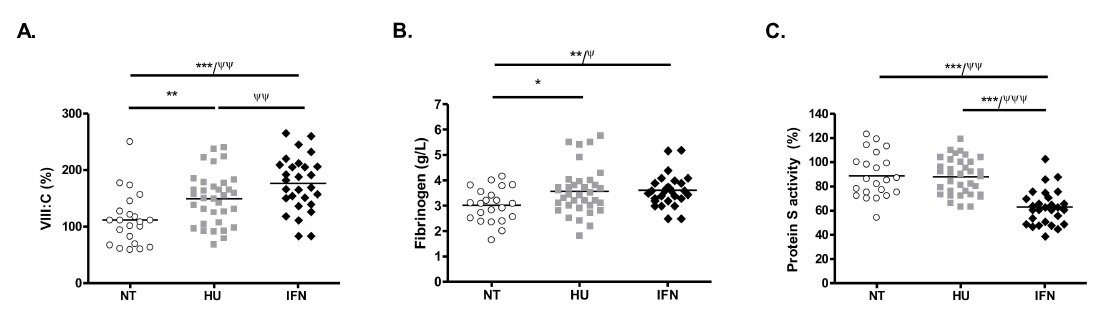
Figure 2. Levels of VIII:C ( A ) fibrinogen ( B ) and protein S activity ( C ) in NT, HU- and IFN-treated patients. Post-hoc pairwise comparisons of parameters were performed using the Mann–Whitney test (* p < 0.05, ** p < 0.01, *** p < 0.001) and logistic regression analysis adjusted for age, sex, and disease type (ET or PV) ( Ψ p < 0.05, ΨΨ p < 0.01, ΨΨΨ p <